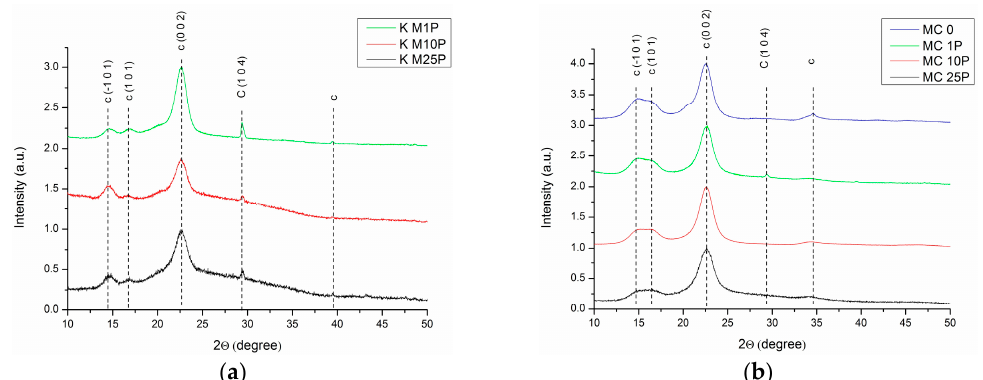
Figure 4. ( a ) XRD patterns of bacterial cellulose from KM at different number of passes through microfluidizer (K_M1P—1 pass; K_M10P—10 passes; K_M25P—25 passes); c—cellulose peaks; C—CaCO 3 impurity. ( b ) XRD patterns of micro-crystalline cellulose at different number of passes through microfluidizer (MC_1P—1 pass; MC_10P—10 passes; MC_25P—25 passes); c—cellulose peaks; C—CaCO 3 impurity.